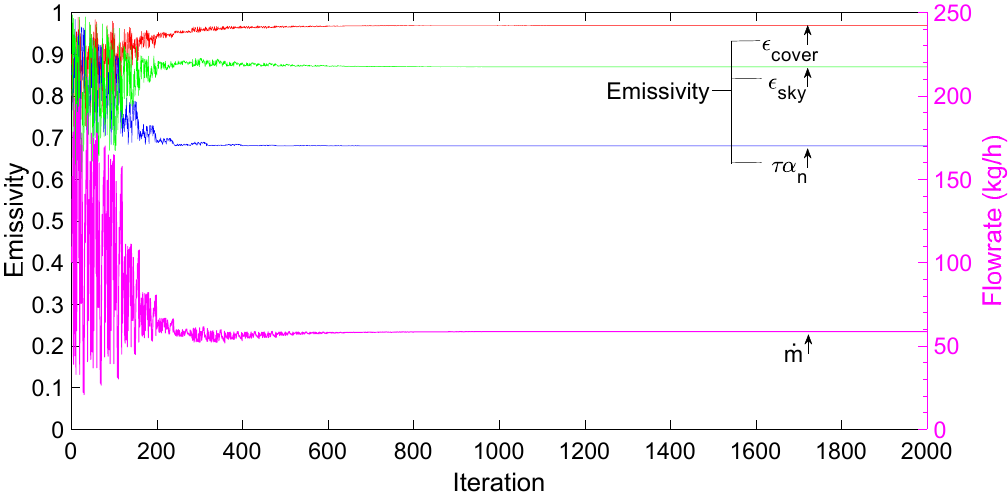
Figure 7. Optimization process results using GenOpt.